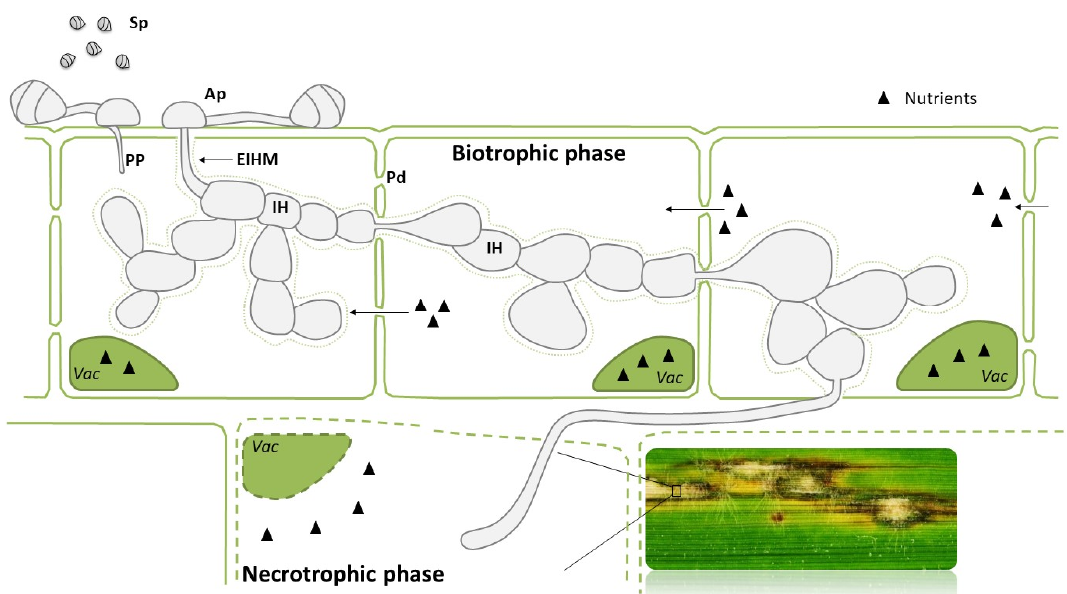
Figure 1. Colonisation of rice leaves by the hemibiotroph fungus Magnaporthe oryzae. The fungus first establishes a biotrophic interaction with the rice plant and later switches to a necrotrophic lifestyle. During the biotrophic phase, the fungus grows inside living host cells. The hyphae are encased by the extra-invasive hyphal membrane (EIHM) which is continuous with the rice plasma membrane. At this stage of the infection process, the fungus uses plasmodesmata for cell-to-cell movement [16,26], and absorbs nutrients from the plant living cells. The host vacuolar integrity in the first invaded rice cells is important for M. oryzae early stages of infection [27]. In the necrotrophic phase, the fungus colonises the host tissue and obtains nutrients from the host dead cells. Ap, appresorium; EIHM, extra invasive hyphal membrane; IH, invasive hyphae; Pd, plasmodesmata; PP, penetration peg; Sp, spores; Vac, vacuole. Black triangles represent plant